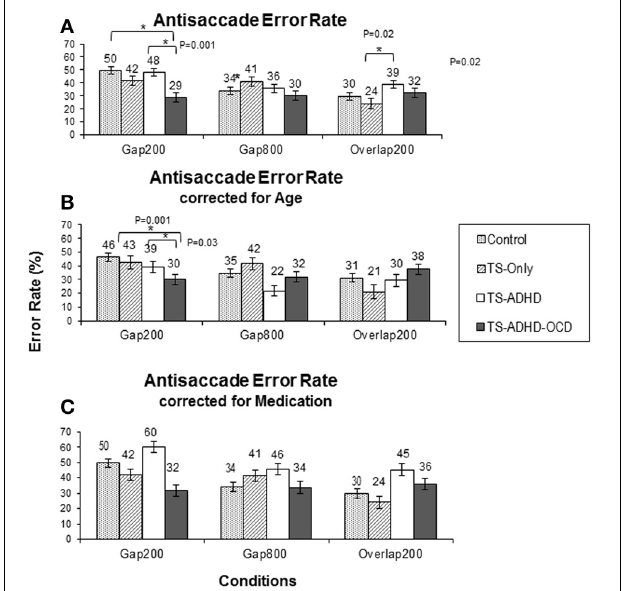
FIGURE 3 | Antisaccade error rates. The top graph (A) displays the mean antisaccade error rates of each group: Control, Tourette-only (TS-only), TS + Attention Deficit Hyperactivity Disorder (TS + ADHD) and TS + ADHD + Obsessive Compulsive Disorder (TS + ADHD + OCD) in different conditions. The middle graph (B) shows the mean antisaccade error rates following Age-adjustments of the groups. Graph (C) depicts the average antisaccade error rates of each group following the data exclusion of the patients taking Risperidone in the TS + ADHD and TS + ADHD + OCD groups. The error bars are standard